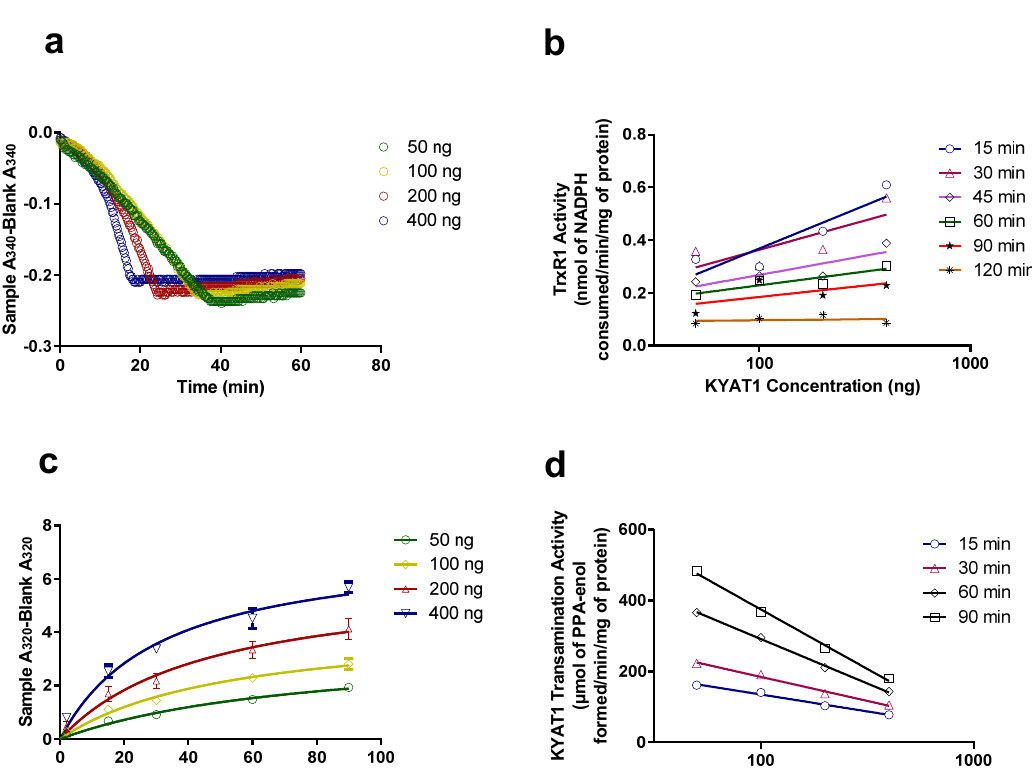
Figure 3. Comparison between beta-elimination and transamination activity. ( a ) Increased KYAT1 concentration increases NADPH consumption by TrxR1. The T max velocity for 50, 100, 200 and 400 ng of KYAT1 enzymes resulted in 49.71, 49.68, 24.0 and 14.65 min, respectively, with 5 mM of MSC as a substrate. ( b ) The activity of the KYAT1 enzyme at varying concentrations with time in the coupled activity assay. ( c ) The transamination activity of KYAT1 at varying enzyme concentration, ½T max velocity for 50, 100, 200 and 400 ng of KYAT1 enzymes resulted in 78.15, 53.0, 46.4 and 31.7 min, respectively. Data are represented as mean ± SD ( n = 3). ( d ) The activity of the KYAT1 enzyme at varying concentrations with time in the transamination assay.